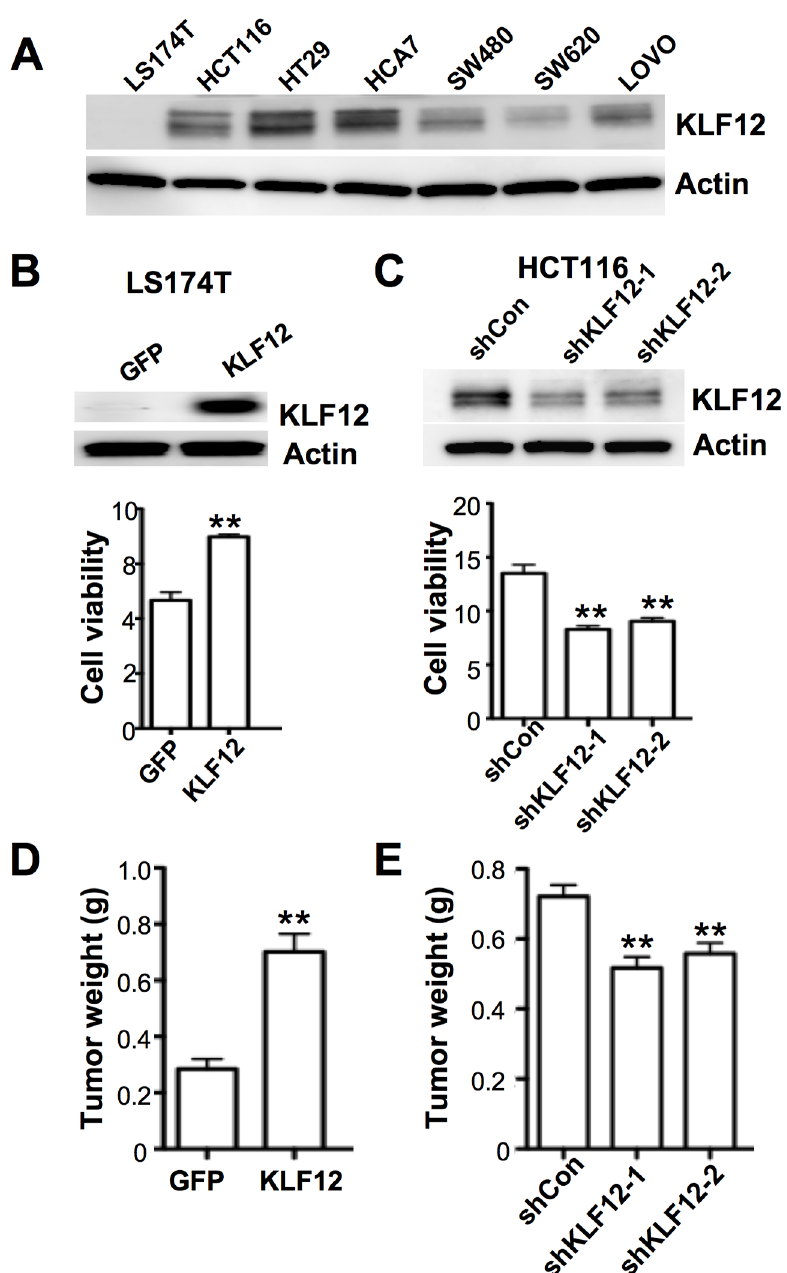
Fig 1. KLF12 promotes tumor growth in vitro and in vivo . (A) KLF12 protein levels in CRC cell lines. Actin served as a loading control. (B) KLF12 expression (top) and cell viability (bottom) of LS174T cells stably transfected with either GFP or KLF12. Actin served as a loading control. C. KLF12 expression (top) and cell viability (bottom) of HCT116 cells stably transfected with either a vector containing nonsilencing control shRNA (shCon) or one of two KLF12 shRNAs (shKLF12-1 and shKLF12-2). Actin served as a loading control. D. Tumor weight in mice orthotopically injected with either LS174T/GFP or LS174T/KLF12 cells (n = 8 for each group). E. Tumor weight in mice orthotopically injected with either HCT116/shCon, HCT116/ shKLF12-1, or HCT116/shKLF12-2 cells (n = 9 for each